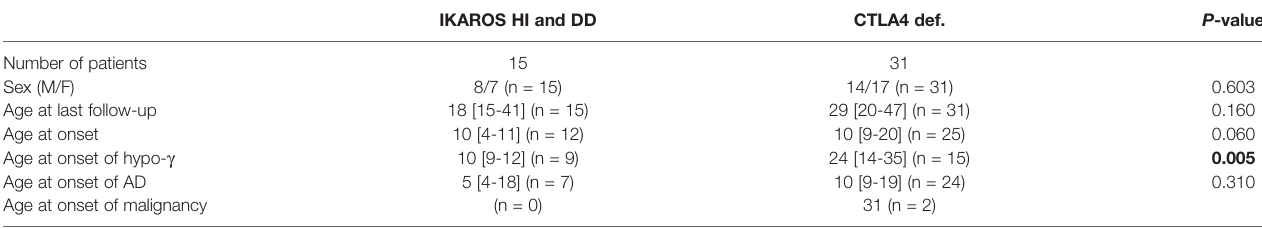
TABLE 2 | Baseline description of individuals with IKAROS de fi ciency (HI and DD) and CTLA4 de fi ciency in the longitudinal study. IKAROS HI and DD CTLA4